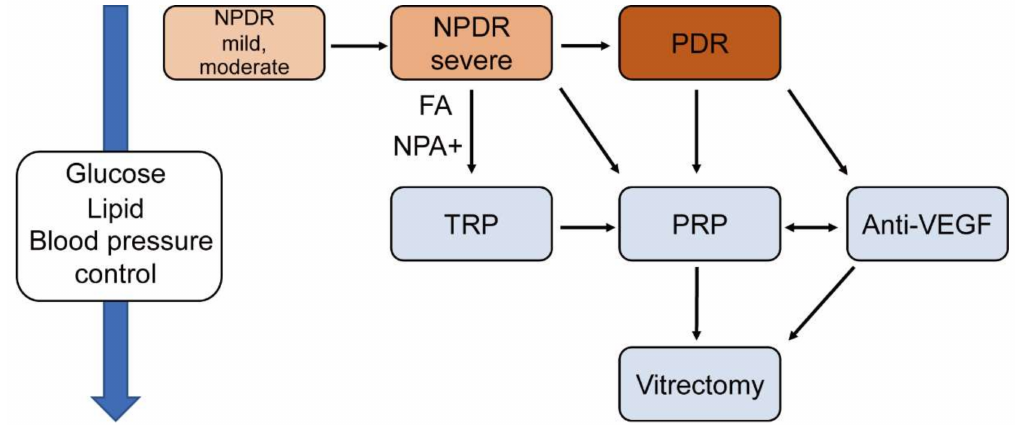
Figure 2. A flowchart of suggested treatment for diabetic retinopathy (DR) without macular edema. DR is categorized as non-PDR (NPDR) and PDR. NPDR falls into three subcategories: mild, moderate, and severe. The control of glucose and lipid levels and blood pressure is crucial at any stage. NPDR; non-proliferative diabetic retinopathy, DME; diabetic macular edema, TRP; Targeted retinal photocoagulation, FA; Fluorescein angiography, NPA; non-perfusion